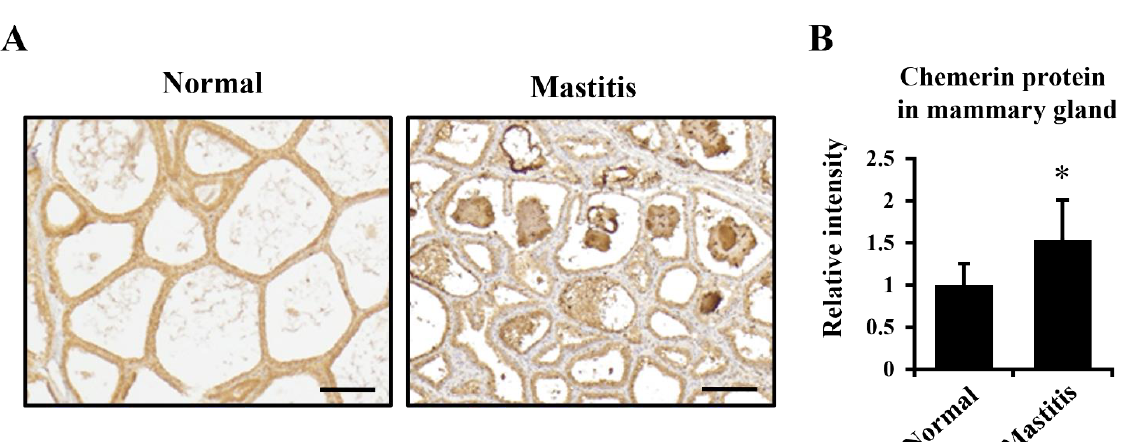
Figure 3. Elevated chemerin production in the mastitic mammary gland. ( A ) Paraffin-embedded sections of normal and mastitic mammary gland tissue from Holstein dairy cows were immunostained to visualize chemerin and its receptors. Scale bar = 200 µ m. ( B ) Total protein was extracted from the sections and subjected to immunoblotting to compare relative levels of chemerin protein between normal and mastitic cows. * p < 0.05 by paired t -test.